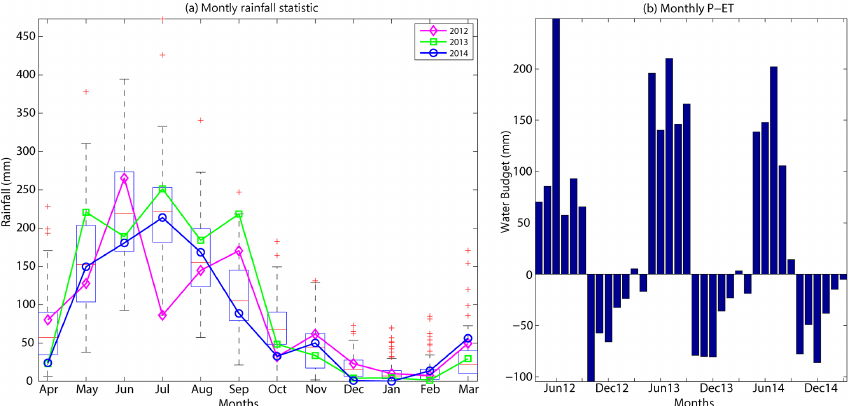
Figure 2. (a) Box plot of monthly rainfall at the Golgotha Cave site. (b) Monthly water budget for 3 observed hydrological years.